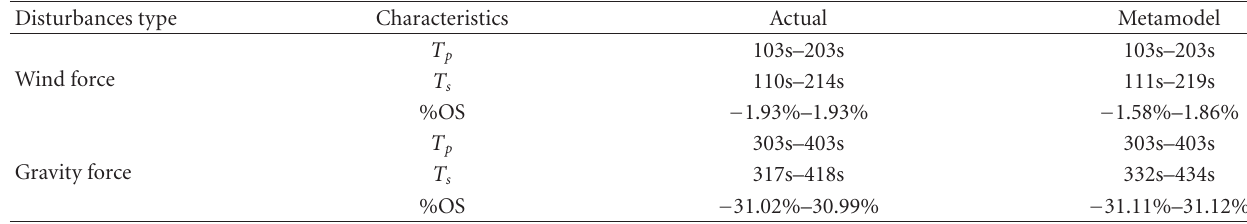
Table 5: System response characteristics for nonlinear model.